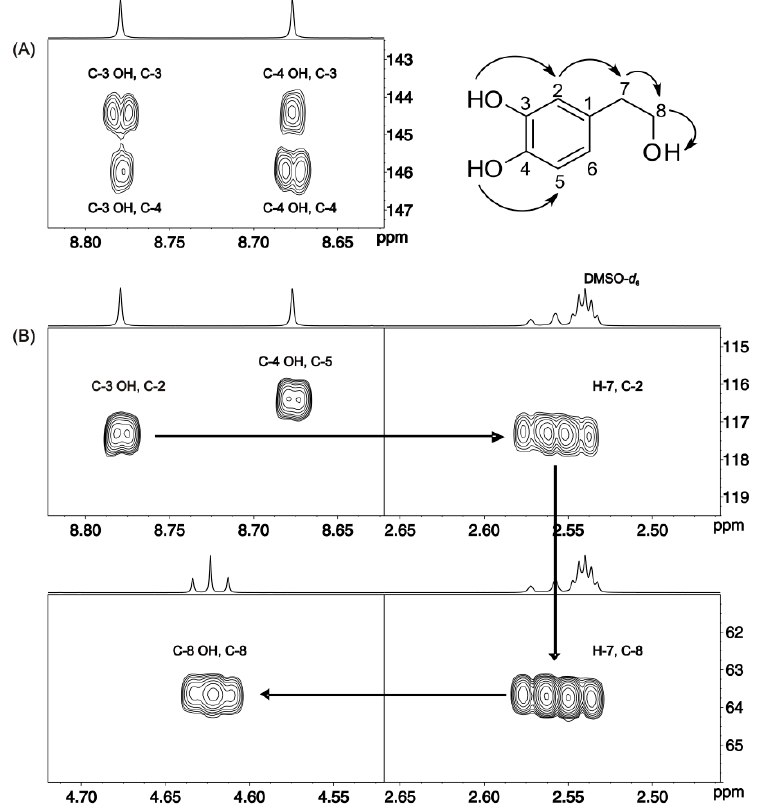
Figure 7. Selected regions of the 500 MHz 2D 1 H- 13 C HMBC-NMR spectrum of the solution of Figure 6B (T = 288 K, number of scans = 8, experimental time = 1 h). The experiment was optimized for n J ( 1 H, 13 C) values for 6 to 8 Hz. Reproduced with permission from [16]. Copyright 2011, by the American Chemical